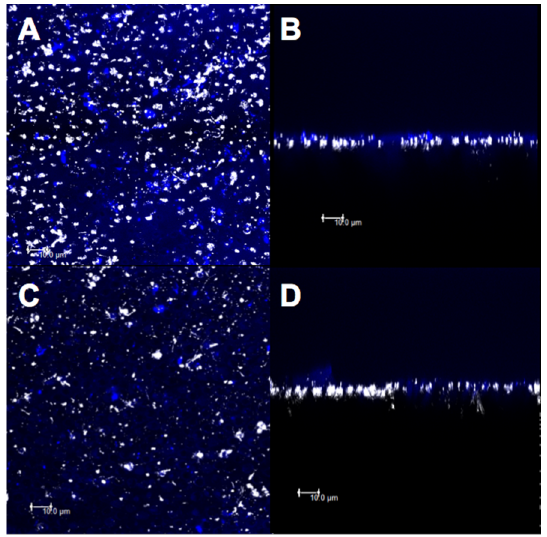
Figure 11. Confocal laser scanning microscopy images (fluorescence mode) in XY and XZ axis of dentin surface. ( A , B ) Fluoride varnish with nanofiber and ( C , D ) after 6% citric acid challenge.